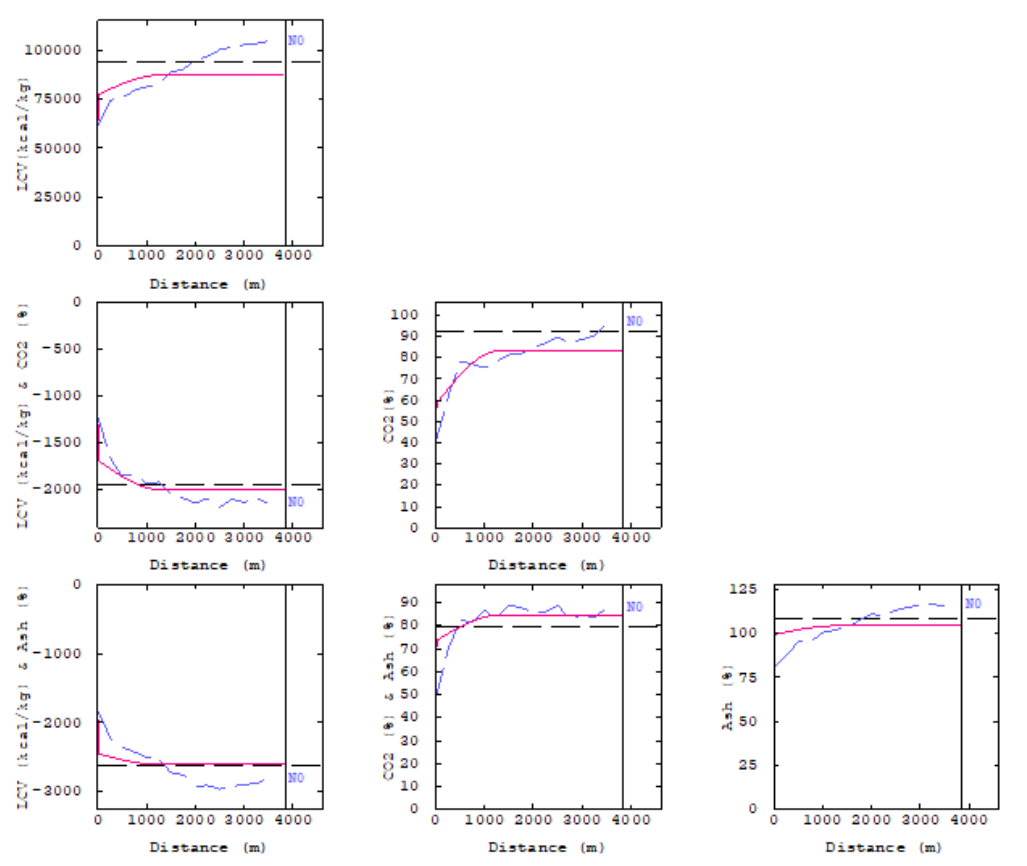
Figure 9. Experimental and model cross variograms for LCV, ash, and CO 2 in the horizontal directions. Experimental structure is modeled by an isotropic spherical variogram. Dashed polygonal lines (blue color) symbolize experimental variograms; thin dashed lines (black color) symbolize variance and covariance; continuous lines (red color) symbolize variogram models.